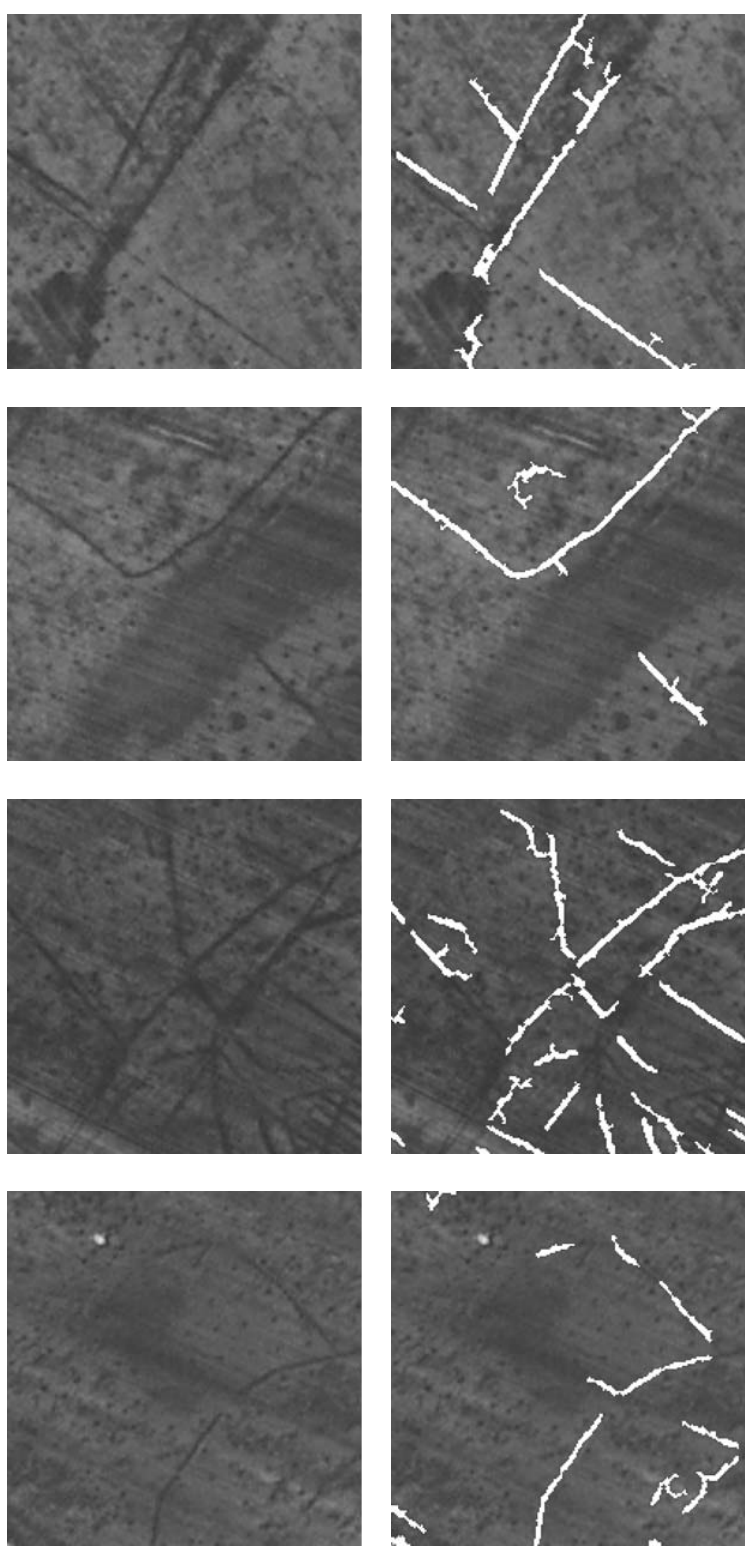
Figure 11. Results of further experiments on the dataset acquired in Apulian Tavoliere . Left column: Starting images. Right column: Corresponding results obtained by the proposed